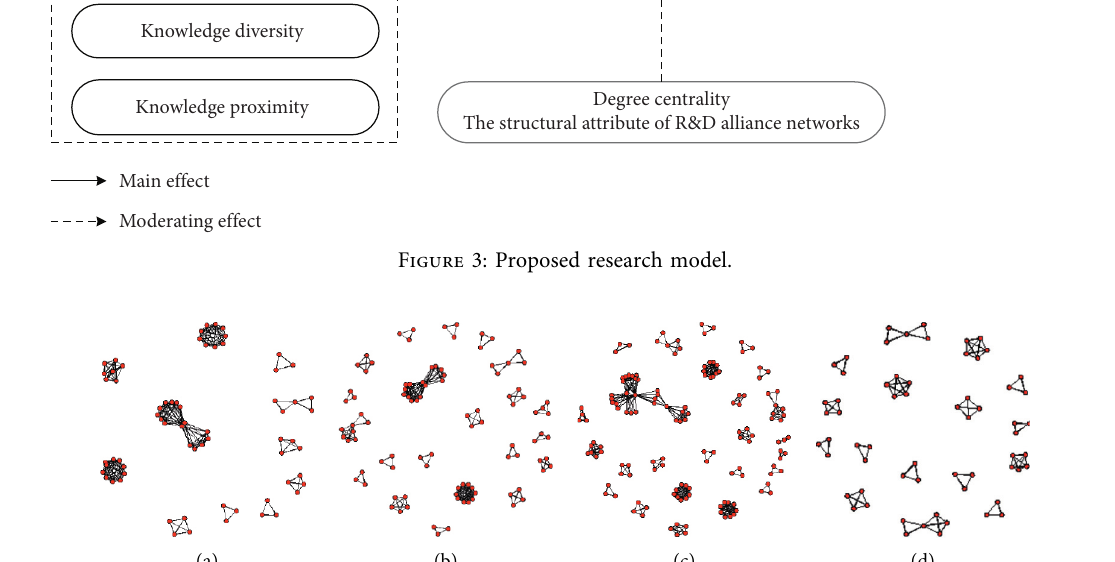
Figure 4: R&D alliance networks in five Chinese high-tech industries from 2010 to 2015 (four time windows from left to